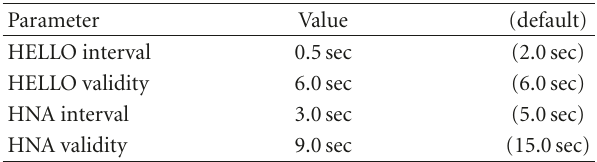
Figure 17: Throughputs of three TCP streams in a field experiment. Performances are less stable than in the indoor case. Table 1: OLSR Parameters for the VANET-only